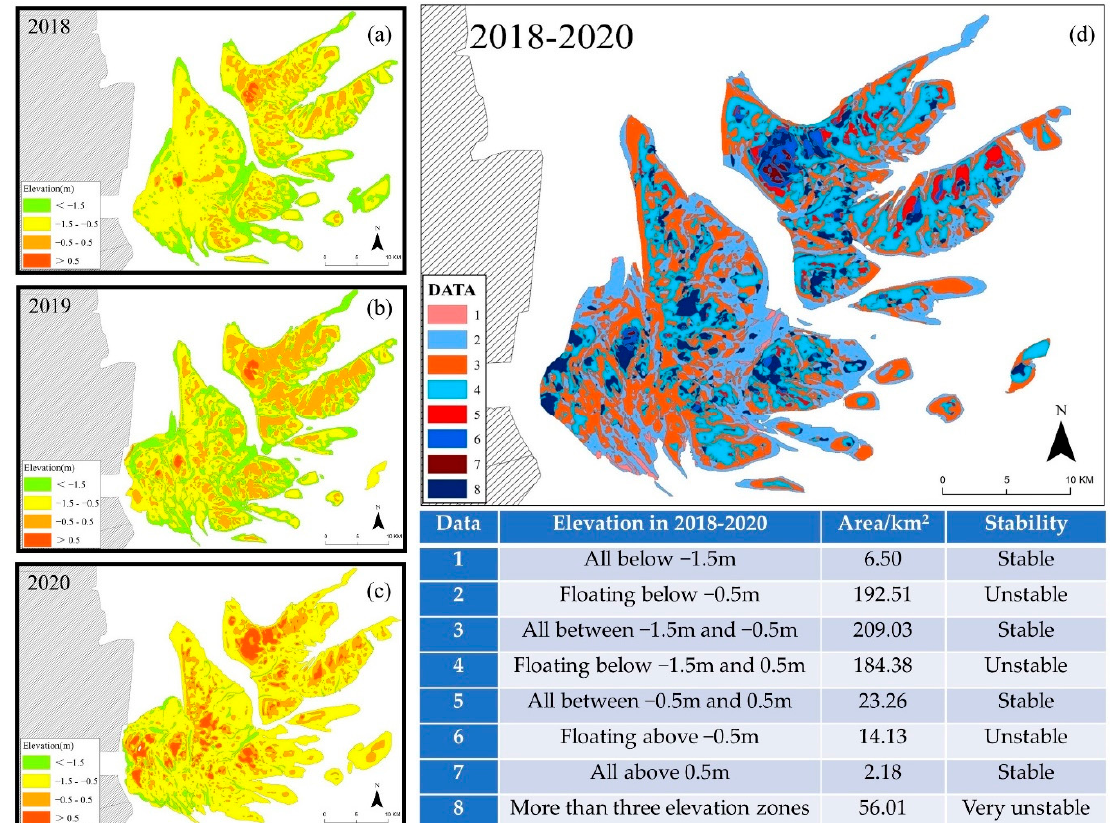
Figure 4. Elevation zone results and stability determination results for the 2018–2020 study area. (( a – c ) Zone results for DEM elevation values for each year; ( d ) sandbank stability determination results for the study area; the table in the lower right corner shows the meaning and area of the values in ( d )).